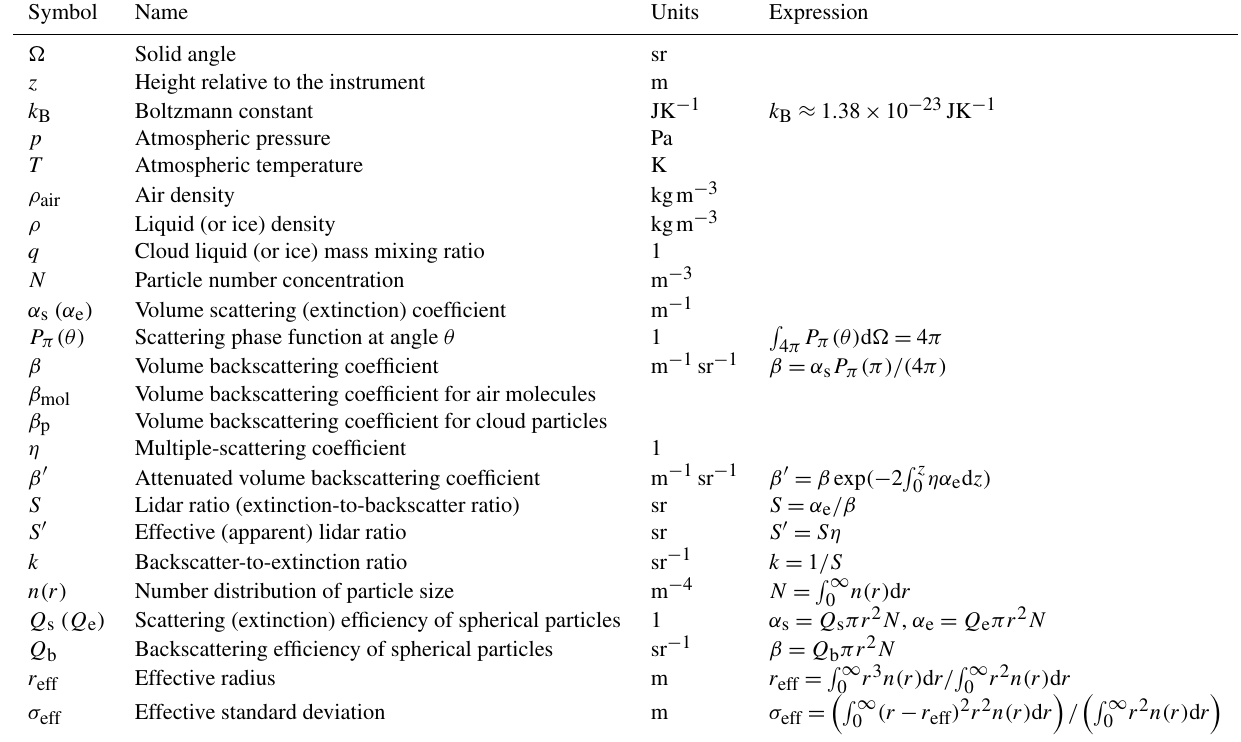
Table 3. Table of physical quantities. Symbol Name